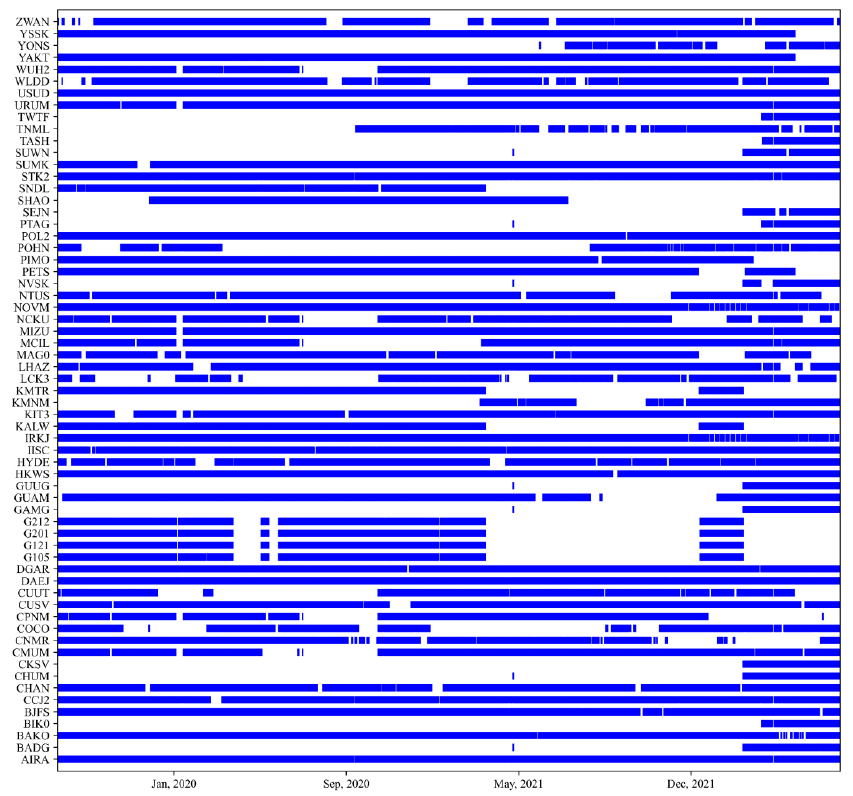
Figure 2. Gantt chart of the time series of PGS observations.